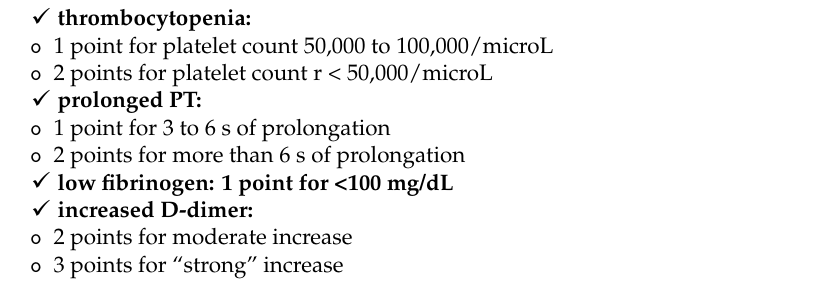
Table 3. The International Society on Thrombosis and Haemostasis (ISTH) scoring system. A ISTH score of 5 or more points suggests DIC is probable.